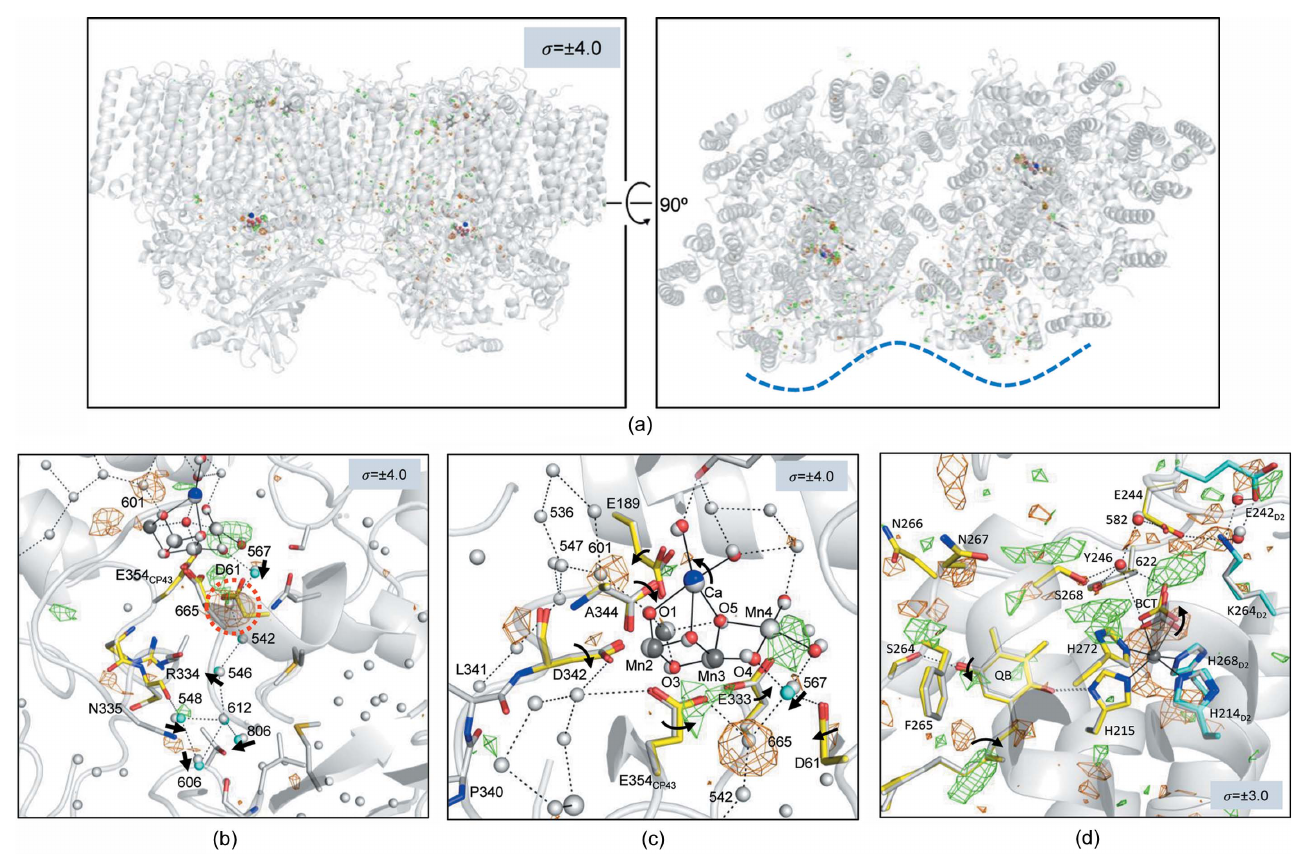
Figure 5 Structures of PSII in the S 1 (gray) and S 2 states (colored) superimposed with an isomorphous difference Fourier map showing ( a ) the overall PSII structure, and the regions of the ( b ) O4 channel, ( c ) OEC and ( d ) Q B site. The difference Fourier map was contoured at (cid:4) 4 (cid:6) ( a )–( c ) and (cid:4) 3 (cid:6) ( d ) in the same color as those in Fig. 3. The surface area where the minor structural changes are distributed is indicated by a blue dashed line. Hydrogen-bonded networks of water molecules are represented by black dotted lines, and the structural changes are indicated by black arrows. W665 is encircled with a red dashed line in ( b